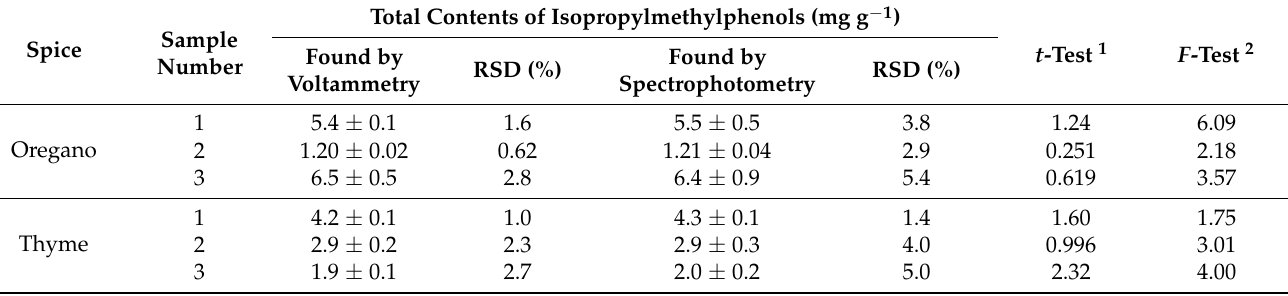
Table 5. Quanti fi cation of the total content of isopropylmethylphenols in spices ( p = 0.95).